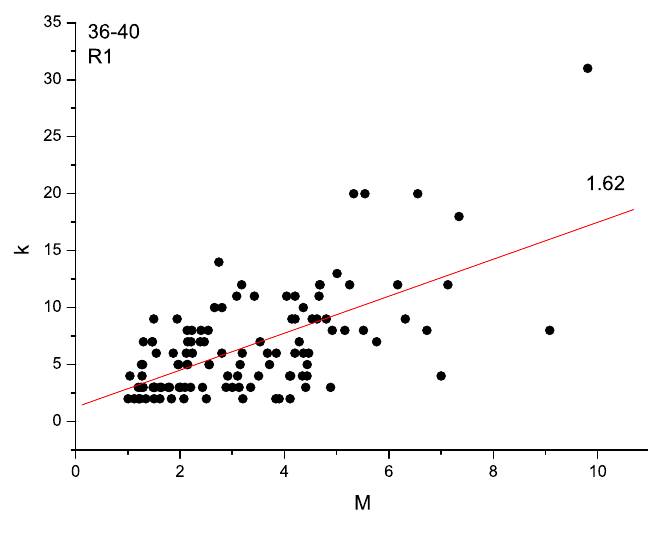
Figure 5. k-M plot and LSM fitting line during run R1.